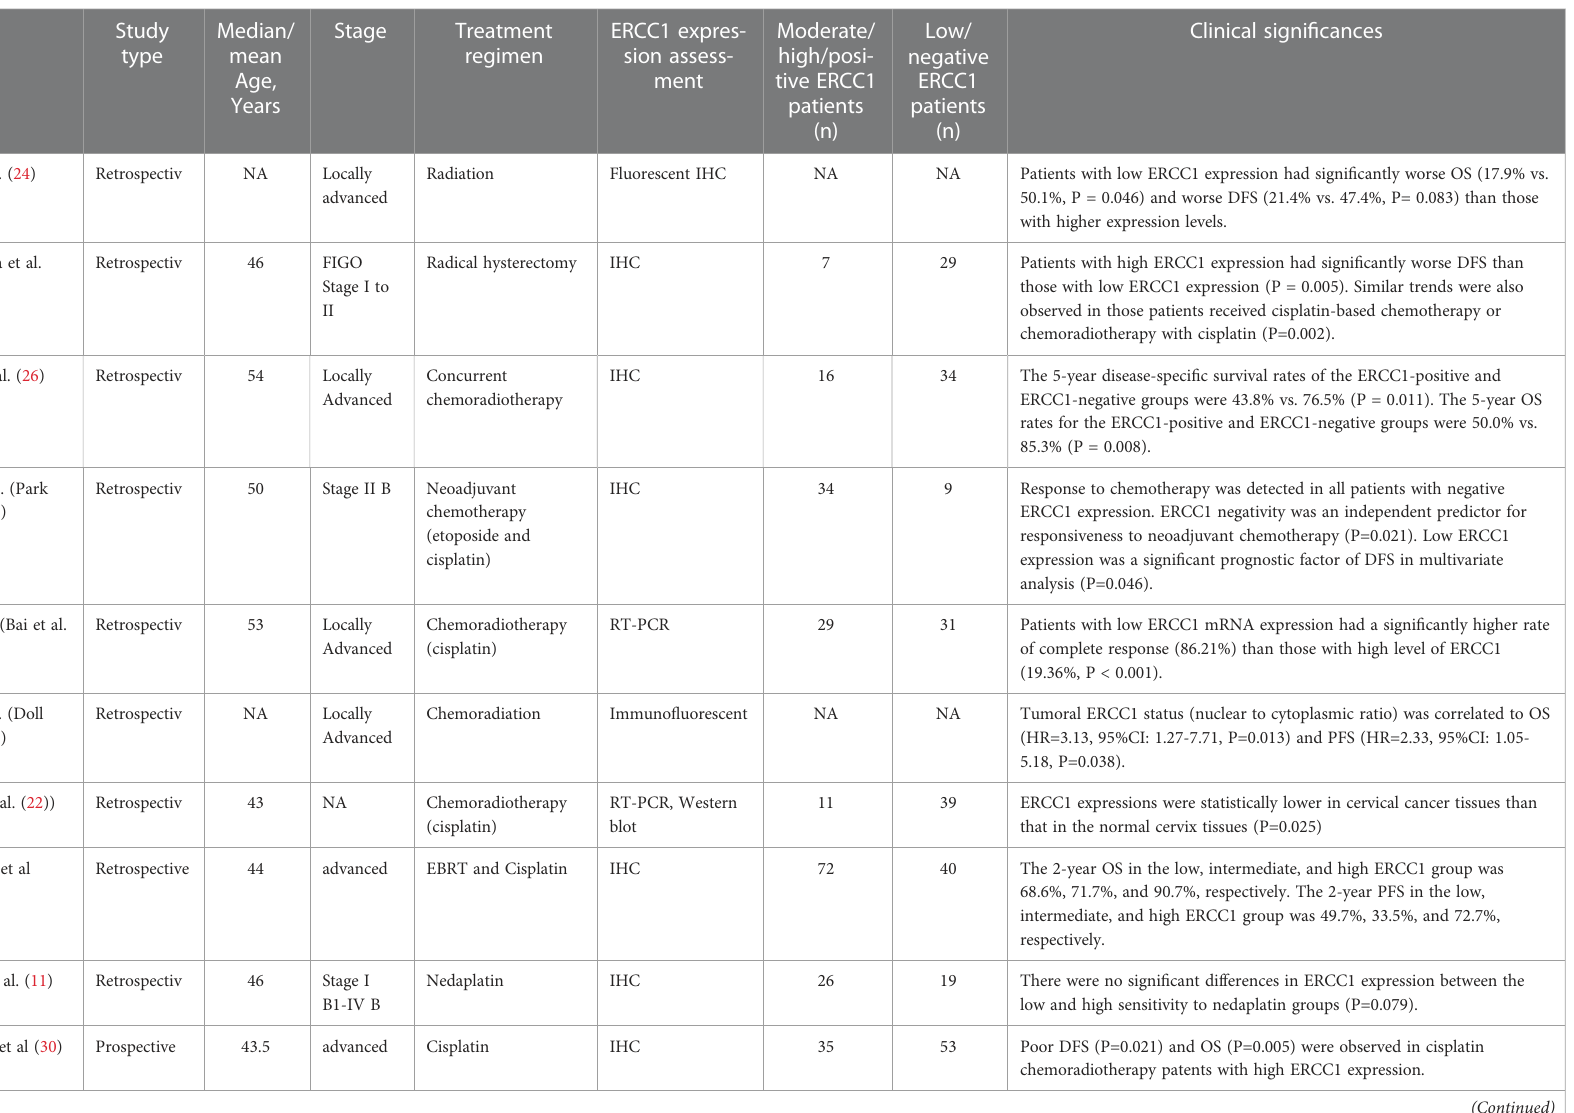
TABLE 1 Clinical fi ndings of ERCC1 in cervical